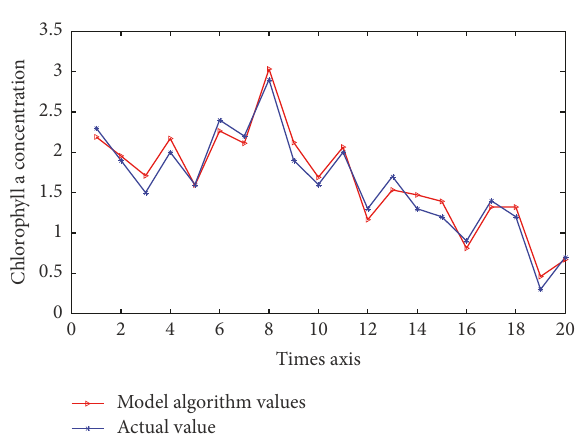
Figure 3: Prediction result of chlorophyll a concentration based on the fuzzy linear regression model.